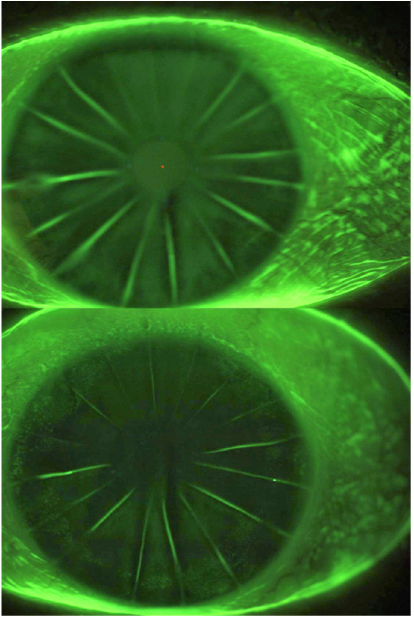
Figure 2. Fluorescein image of both eyes measured with static fluorescein software. Right eye on the top and left eye on the bottom.